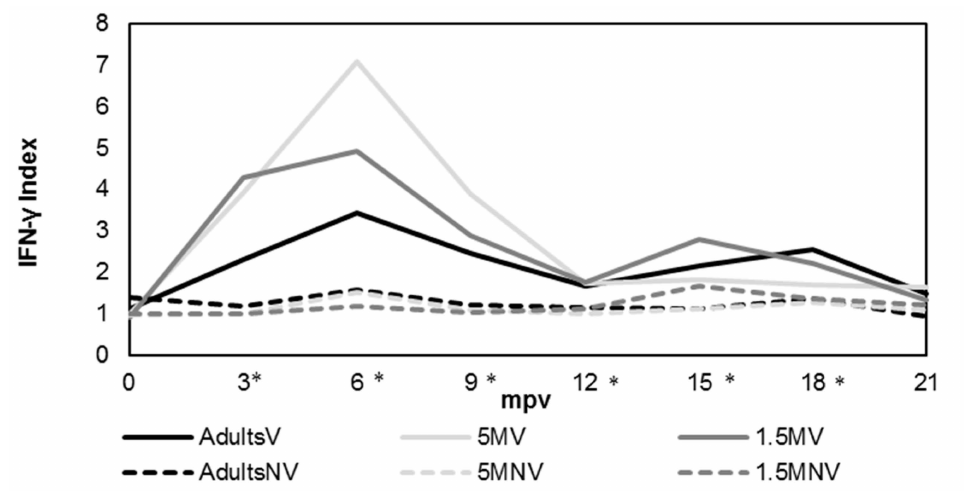
Figure 3. Evolution in the INF- γ production after stimulation of blood with avian PPD according to each experimental group. AdultsV: vaccinated at more than 1.5 years; AdultsNV: not vaccinated at more than 1.5 years; 5 MV: vaccinated at 5 months; 5 MNV: not vaccinated at 5 months; 1.5 MV: vaccinated at 1.5 months; 1.5 MNV: not vaccinated at 1.5 months; mpv: months post vaccination; * significant differences ( p < 0.05) among vaccinated and not vaccinated groups. Results were expressed as a quotient between the mean O.D. of the avian PPD-stimulated plasma and the mean O.D. of the same plasma incubated with PBS.